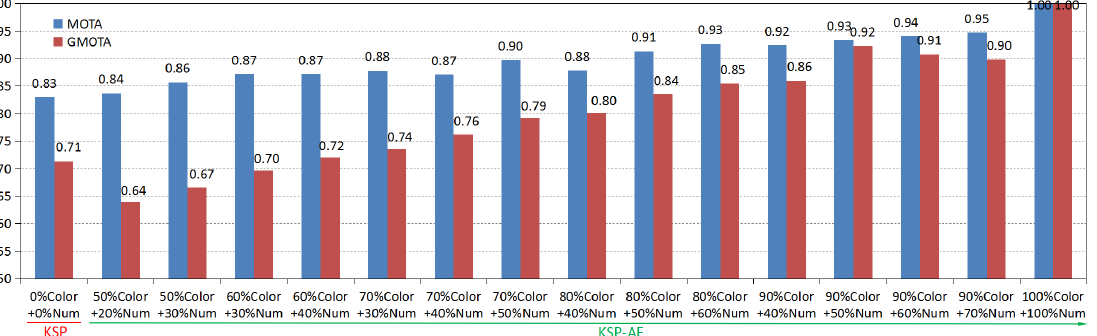
Figure 10. The tracking performance of KSP-AF is gradually improved when more and more jersey colors and jersey numbers are given: (1) 0%Color+%0Num corresponds the original KSP; (2) under KSP-AF, both the MOTA and GMOTA scores gradually increase when more appearance information (e.g., jersey color and jersey number) can be extracted; (3) this experiment is done with APIDIS